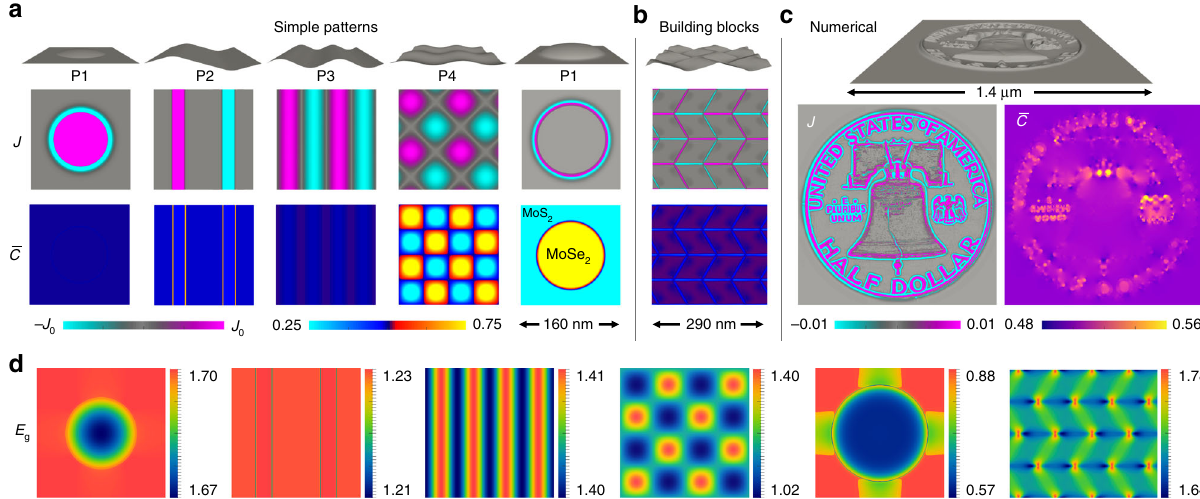
Fig. 2 Shape ! composition programming with MoSeS monolayers. Simulated equilibrium composition patterns ( J and (cid:1) c ) generated at 1023 K by the topographies shown at the top of each column. a Simple patterns (see the fi rst column of Table 1 for expressions), b A Miura-ori pattern that employs P2 as a building-block structure, c An elaborate pattern obtained via our numerical programming approach. In a and b , the J scale is set to the predicted maximum J 0 of each topography (second column of Table 1), while the (cid:1) c scale varies from 0 : 25 to 0 : 75. The last column in a shows a large amplitude P1 template (large stretching) that generates an in-plane MoS 2 /MoSe 2 heterostructure. Regions in gray in the Janus degree maps represent J ¼ 0. d Maps of electronic bandgap E (in eV) for the fi ve patterns shown in a and the Miura-ori pattern in b , based on DFT calculations of the composition and strain g dependent bandgaps in refs. 60,68,69 . See Supplementary Note 2 for more